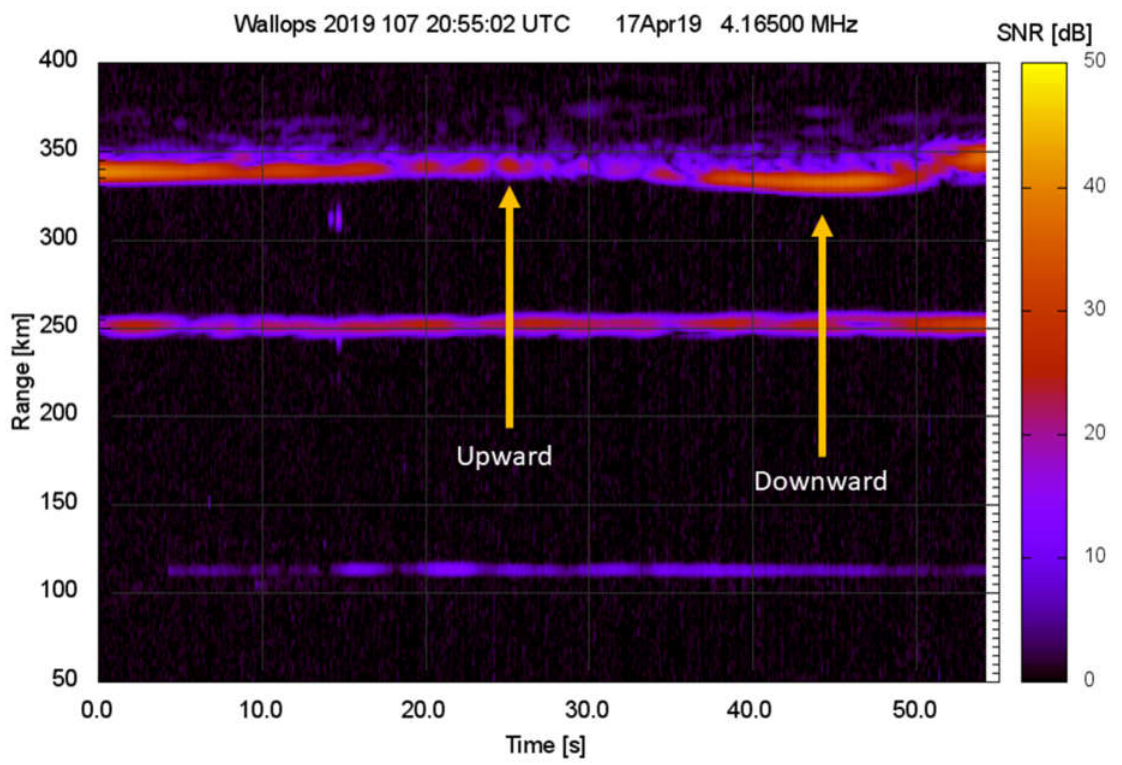
Figure 5. Fixed frequency ionogram when the NG-11 HAAW arrives at the O-mode fixed frequency observation altitude. Start time is the same as in Figure 1, and arrival times of the initial upward and large amplitude downward plasma displacements are identified as ‘Upward’ and ‘Downward’. The large amplitude upward plasma displacement occurs when the VIPIR is not transmitting, so any effects are not identified.